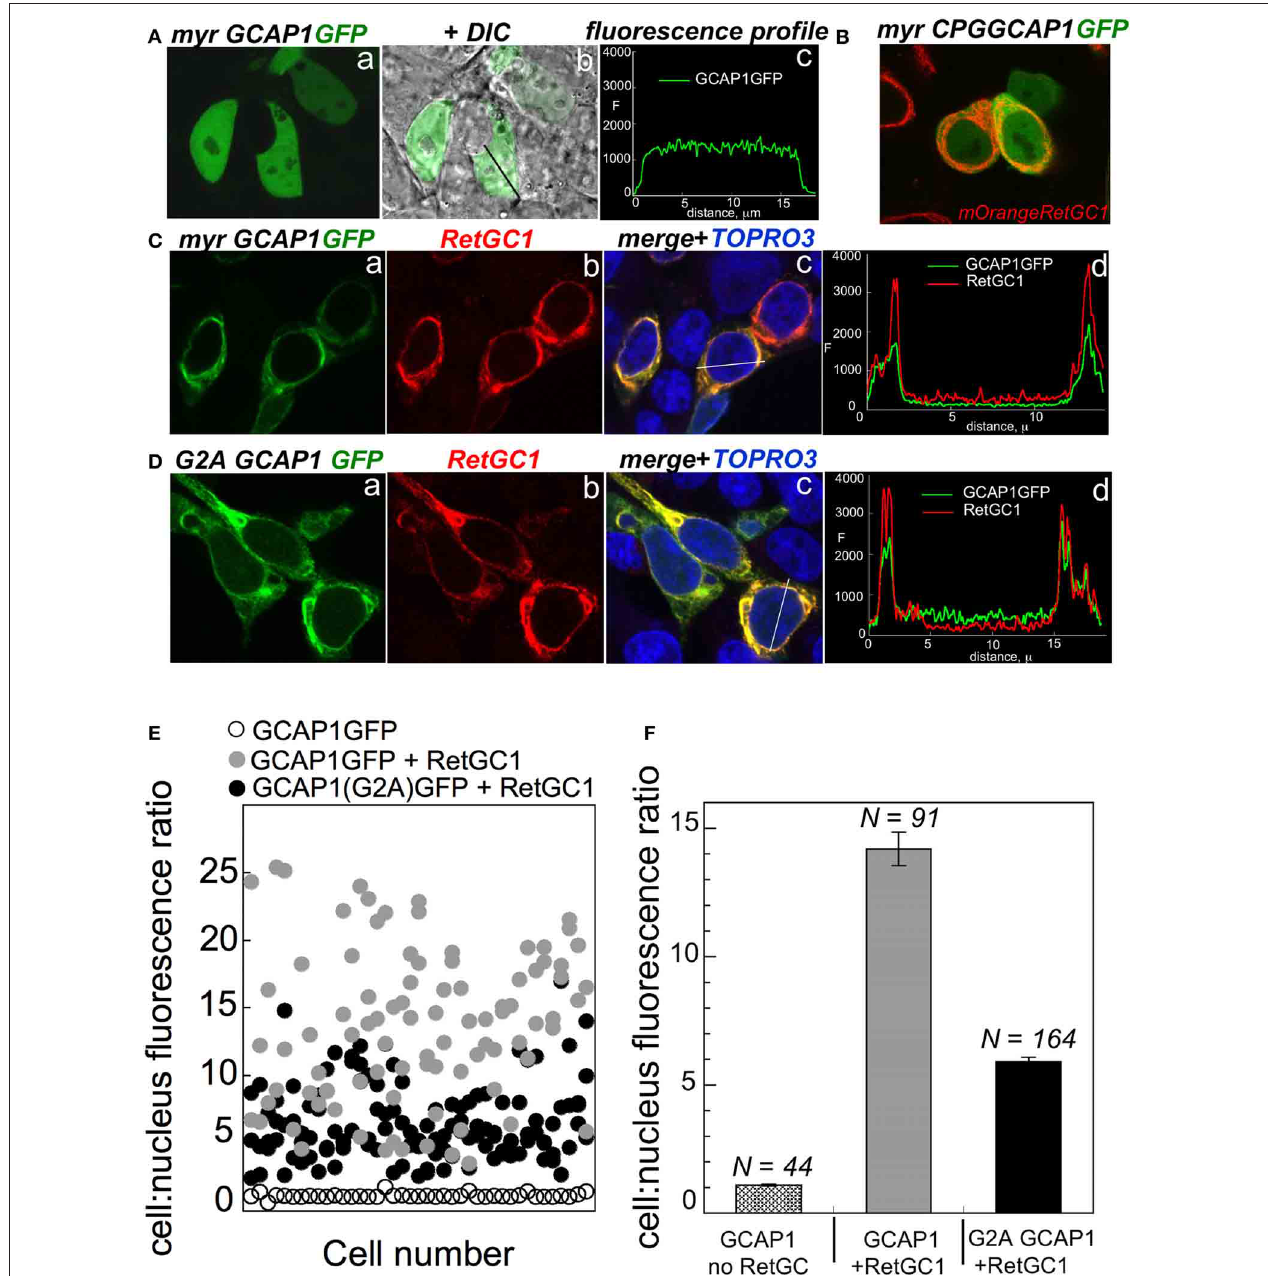
FIGURE 2 | The effect of myristoylation on co-localization of GCAP1 with RetGC in HEK293 cells. (A) GCAP1-GFP expressed in HEK293 cells without RetGC1 produces diffuse pattern spreading over the cytoplasm and the nucleus (Peshenko et al., 2008); a —fluorescence of GCAP1-GFP, b —same, but superimposed on DIC image of the cells, c —GCAP1 GFP fluorescence profile recorded across the cell along the black line in “ b .” (B) GCAP1 GFP mutant, in which a conserved CysPro pair in EF-hand 1 loop required for interaction with RetGC is replaced by Gly (Hwang et al., 2004), was co-expressed with RetGC1 tagged at the N-terminus with mOrange variant of red fluorescent protein using protocol described in (Peshenko et al., 2008, 2011); notice that the diffuse pattern of GCAP1-GFP persists despite the presence of RetGC1. (C) Membrane localization of wild type GCAP1-GFP ( green ) co-expressed with RetGC1 ( red ); a —fluorescence of